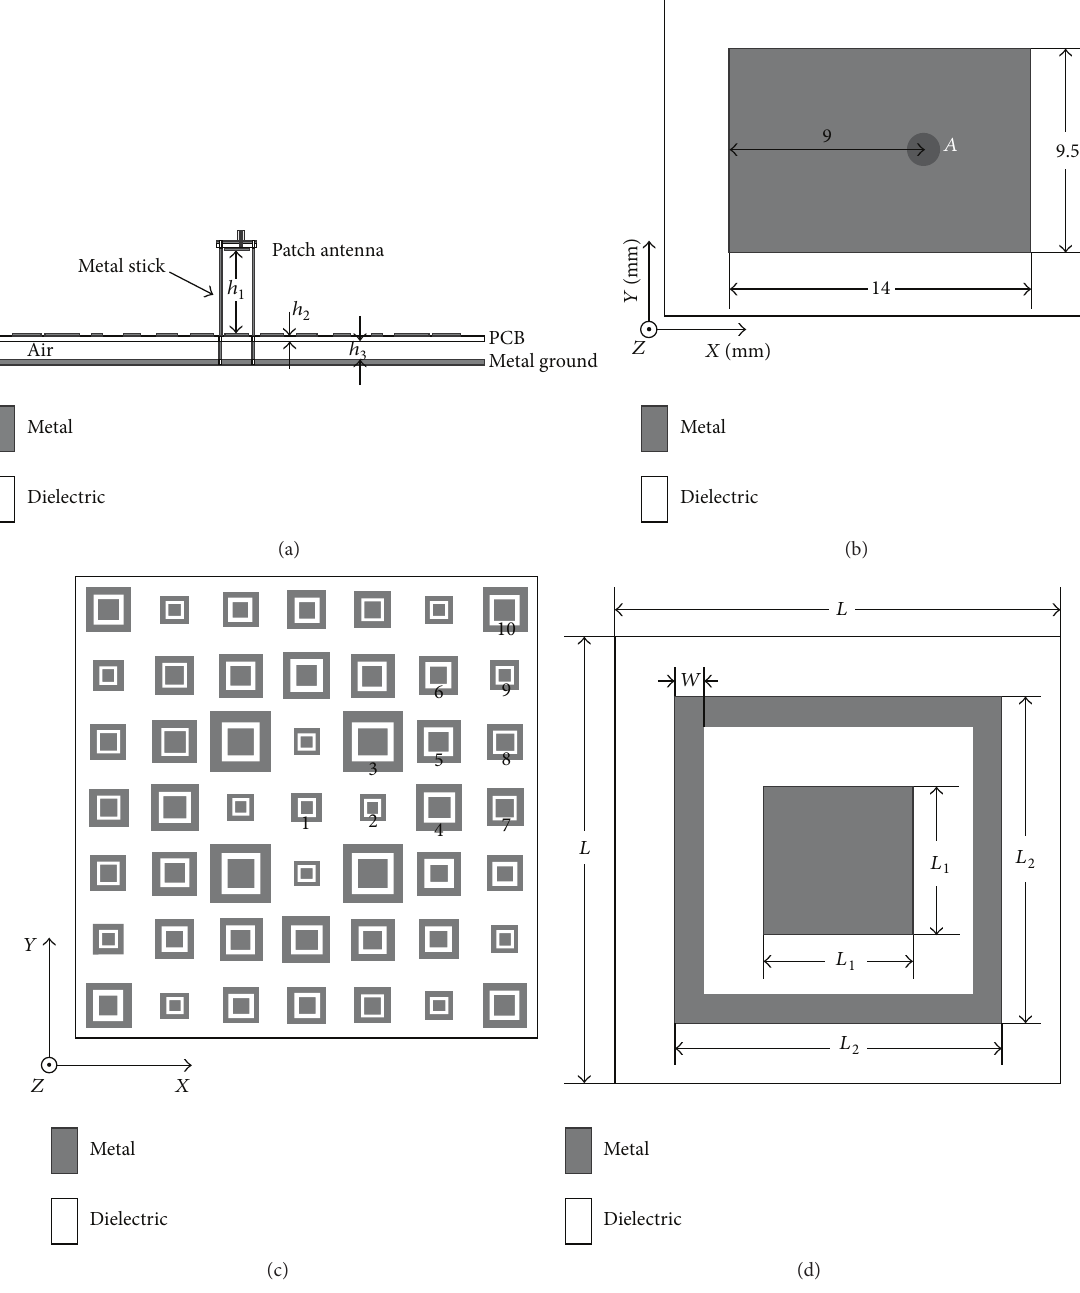
Figure 1: The configuration of the microstrip reflectarray antenna: (a) side view of the reflectarray antenna; (b) top view of the patch antenna; (c) top view of the reflector; (d) configuration of a reflection